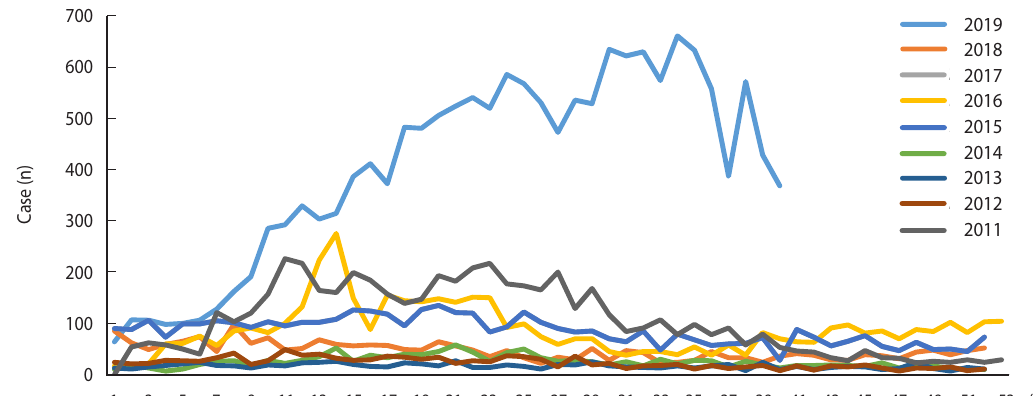
Figure 2. Weekly reported cases of hepatitis A in Korea, 2011-2019 (as of 40th week).